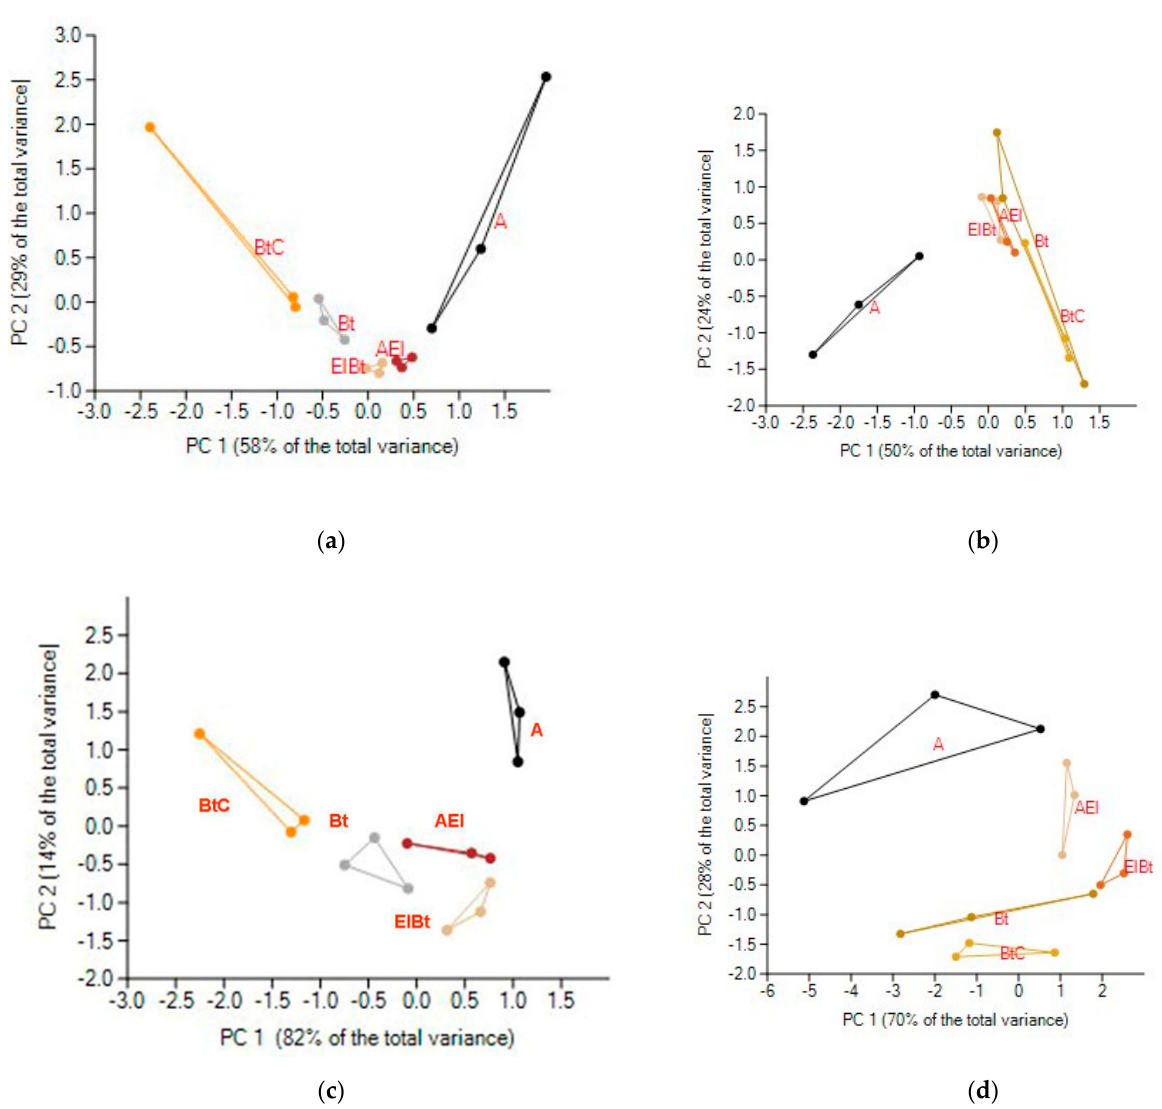
Figure 7. Location of the Phaeozem genetic horizons in the plane of the first two principal components of the data matrix with bacterial ( a ) or fungal ( b ) OTU-specific sequence relative abundance bacterial ( c ) or fungal ( d ) α -diversity indices as variables for analysis and soil samples as objects.